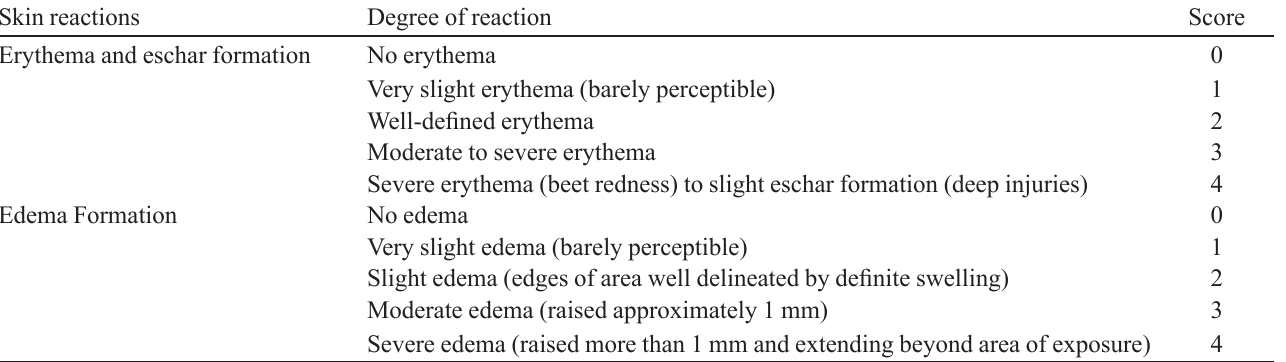
TABLE II - Evaluation of guinea-pig skin reactions in cutaneous irritation tests Skin